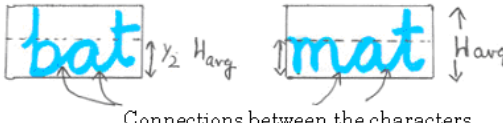
Figure 1: Connections between the characters of a word in cursive hand-written text. Algorithm 1 VerticalSegment I